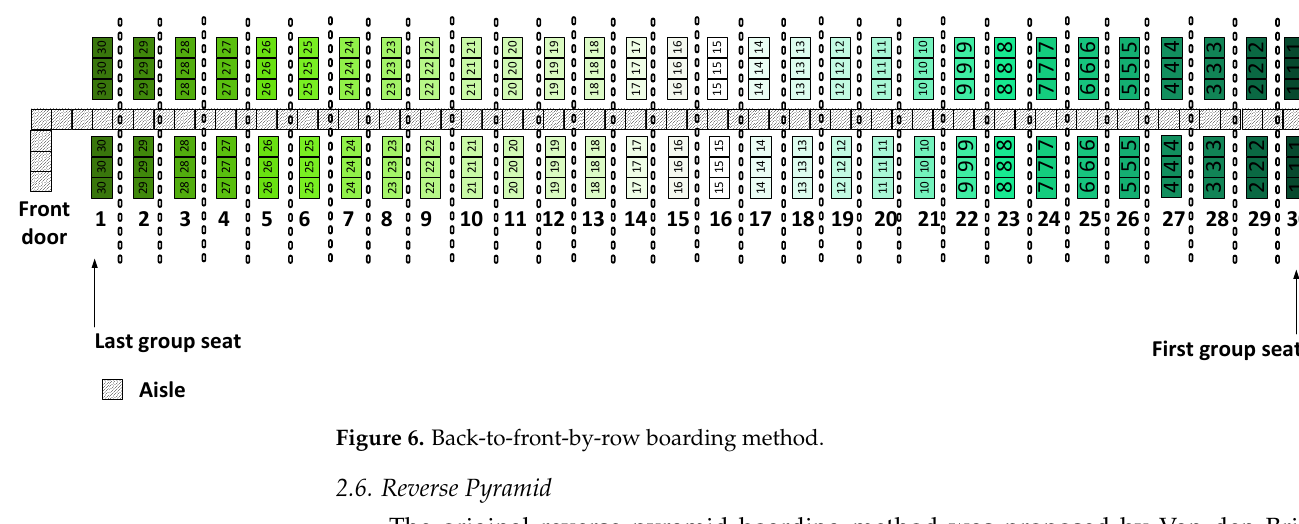
Figure 6. Back-to-front-by-row boarding method.